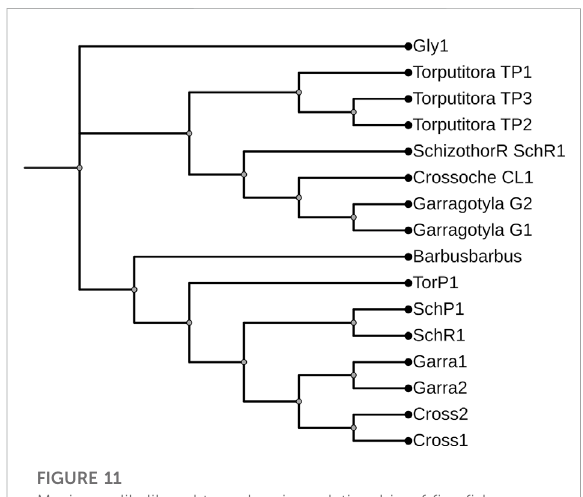
Maximum likelihood tree showing relationship of fi ve fi sh species of River Poonch based on combine data. The maximum likelihood tree was generated using GTR+G